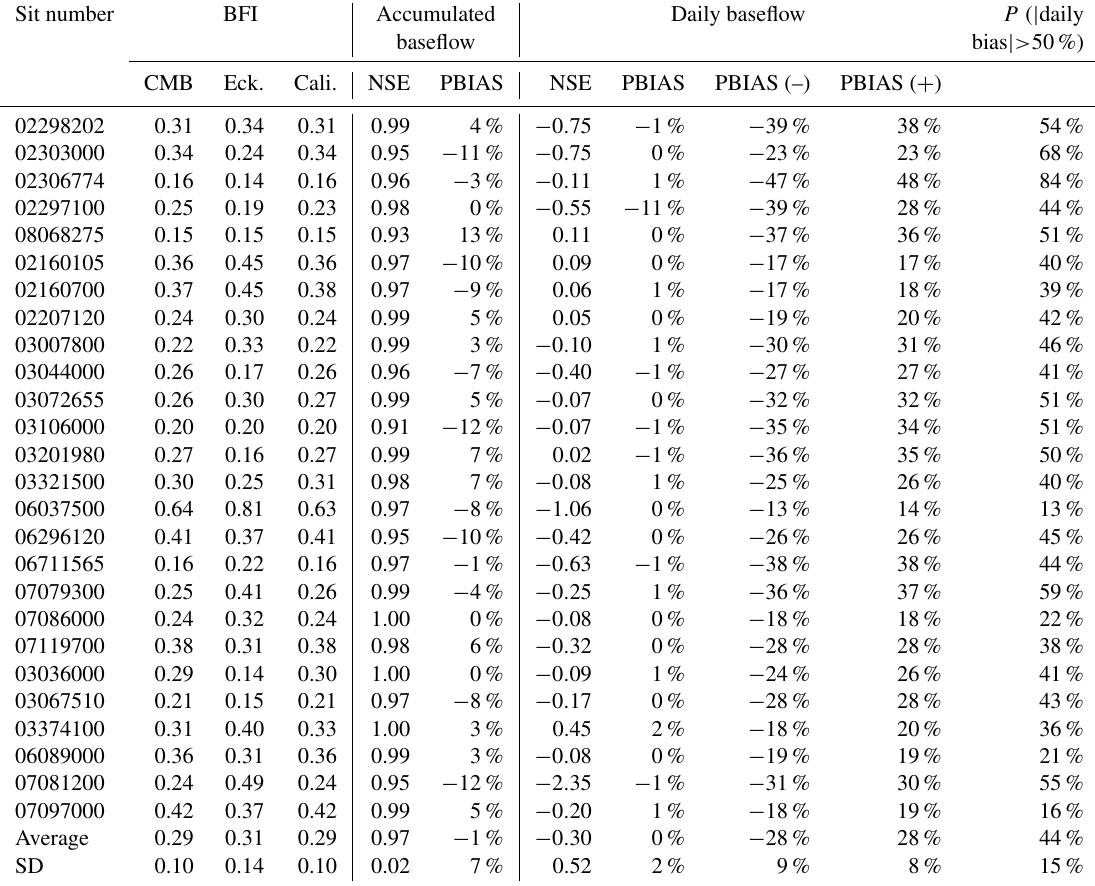
Table 1. The results of baseflow separation of streamflow from 26 hydrological stations of the United States Geological Survey (USGS) National Water Information System (NWIS) before and after calibration. “Eck.” represents the uncalibrated Eckhardt method whereas “Cali.” represents the calibrated Eckhardt